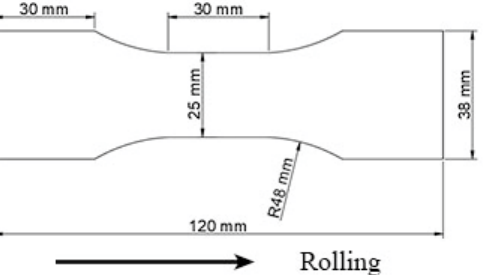
Figure 1. Dimensions of the 12.5 mm-thick tensile and fatigue specimens.